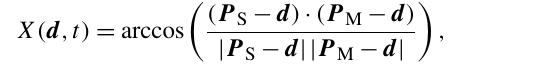
Figure 2. Graphical illustration (not to scale) of the Sun and Moon with definitions of various geometrical quantities. R S , P M and P S are obtained from JPL Horizons and allow calculation of R M and X for arbitrary d .